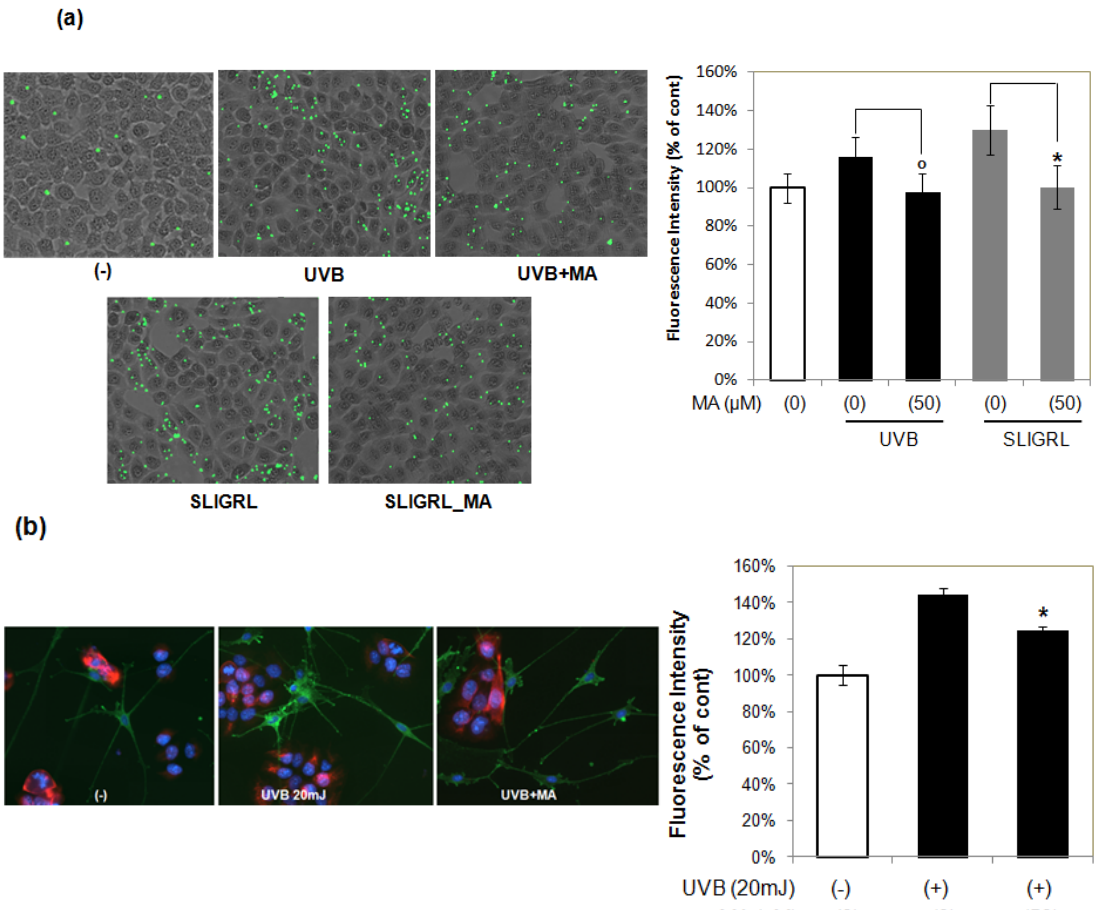
Figure 4. Effect of MA on melanosome phagocytosis. ( a ) Microsphere-based phagocytosis assay. o p < 0.05 vs. UVB-irradiated control; * p < 0.05 vs. SLIGRL treated